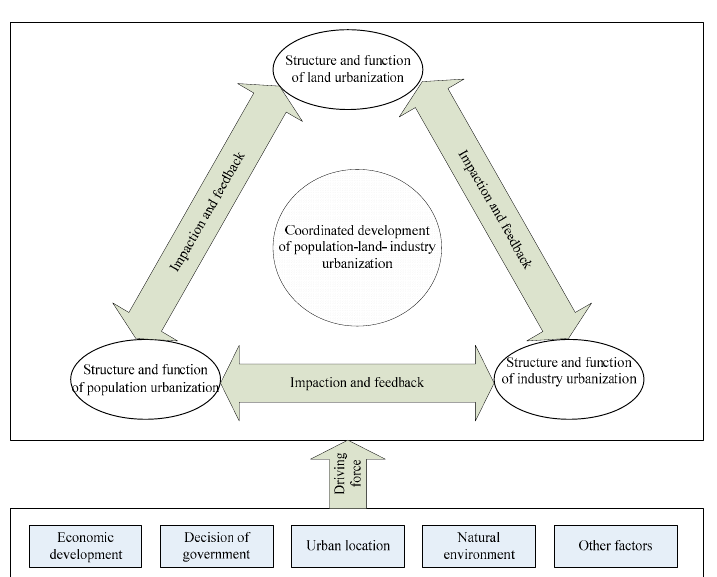
Figure 2. The driving mechanism of PLIU coordination development.